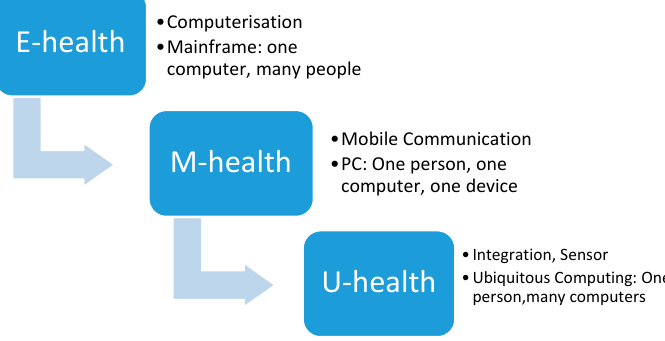
Figure 4. Evaluation of computing (summarized by the authors).